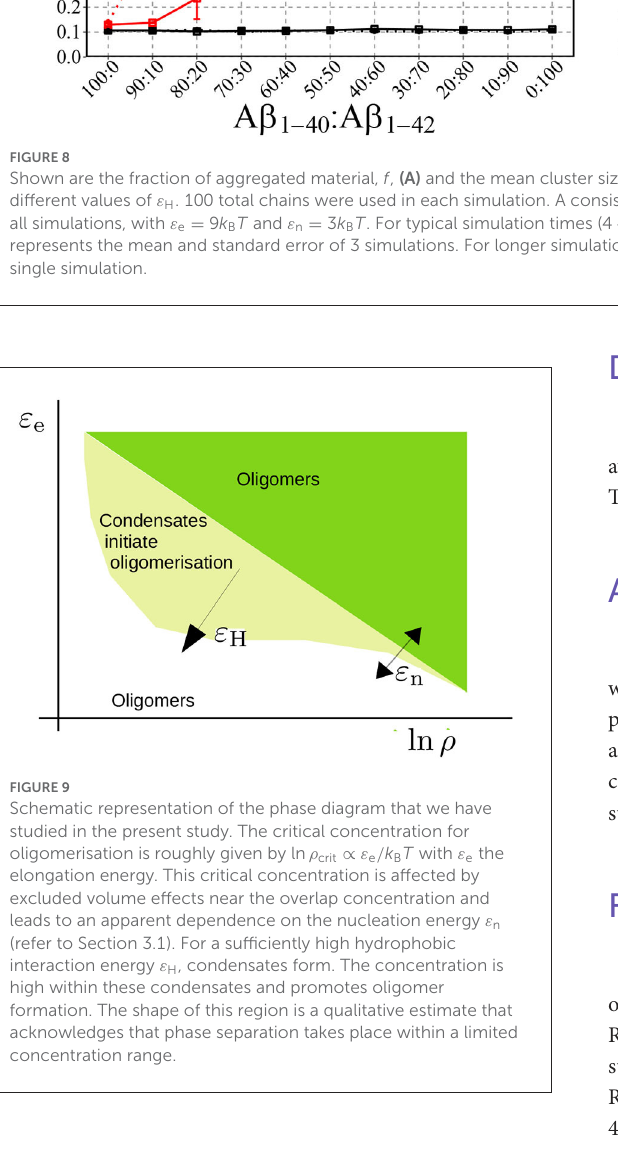
9 k B T and ε n 3 k B T . For typical simulation times (4 = =